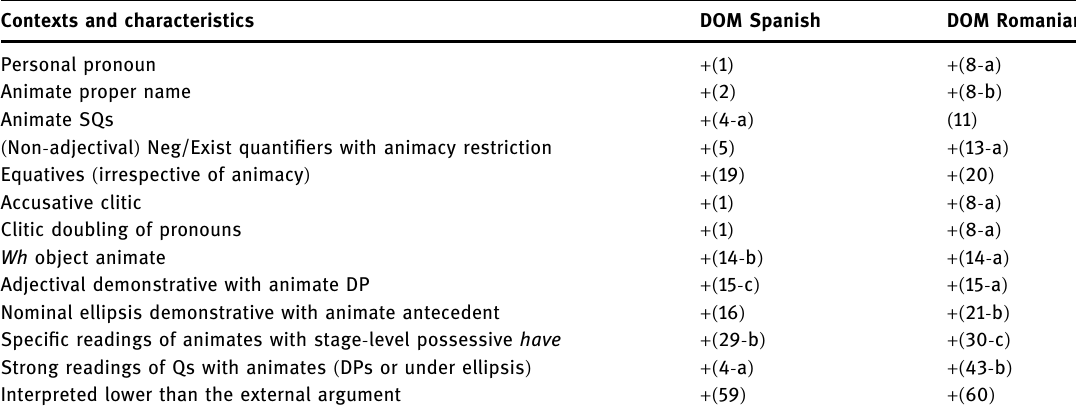
Table 11: DOM similarities – standard Spanish and Romanian Contexts and